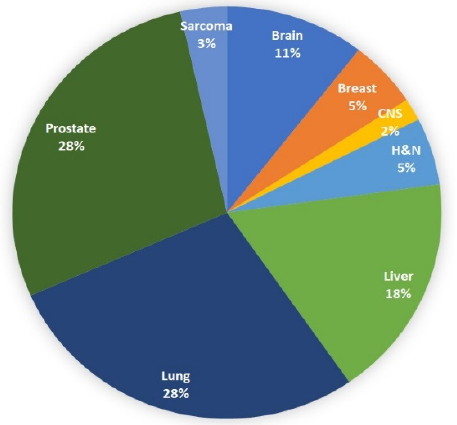
Figure 2. Distribution of treatment sites in reviewed publications.